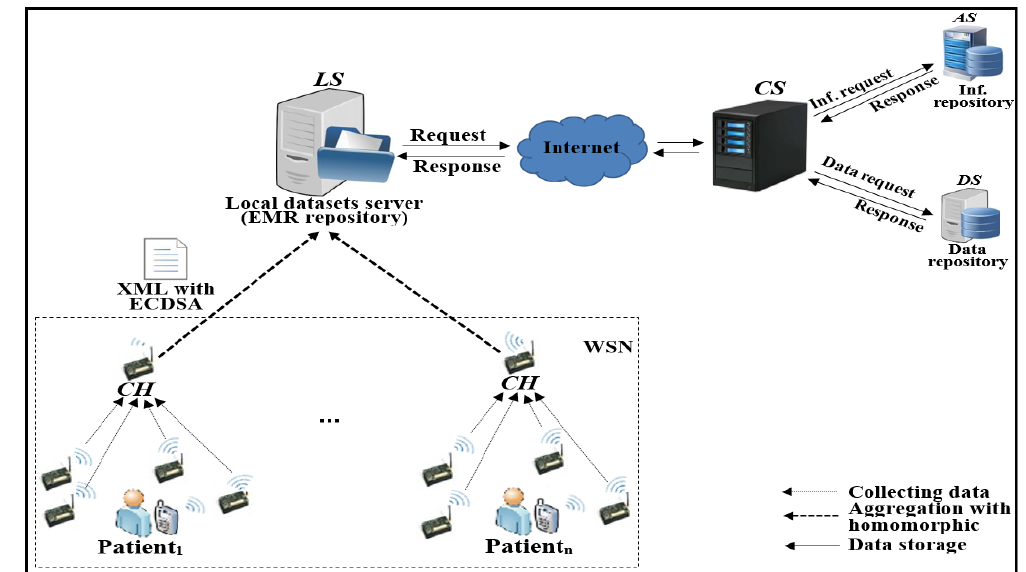
Figure 4. General REISCH